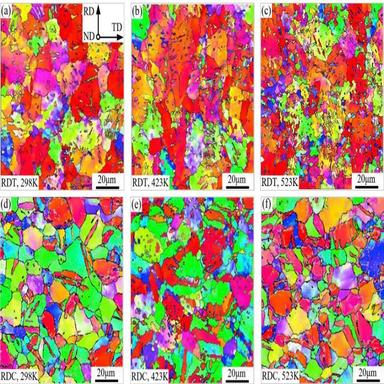
Microstructure of the α-Ti tube after 20% tension/compression deformation along the RD at different temperatures, showing that the grain orientation changes a bit in tension but much in compression.